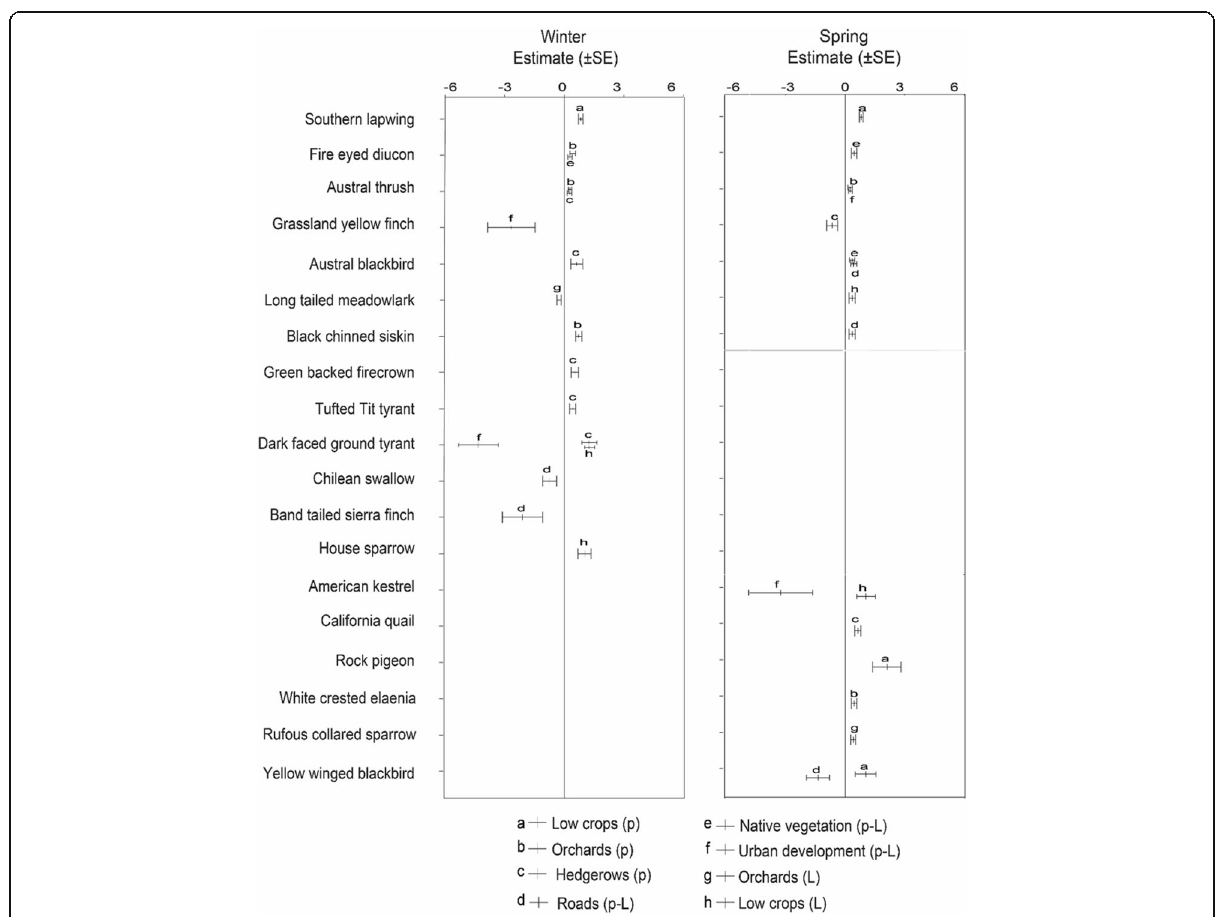
Fig. 4 Relationship between species and land covers and scales during winter ( left ) and spring ( right ). Only significant results are